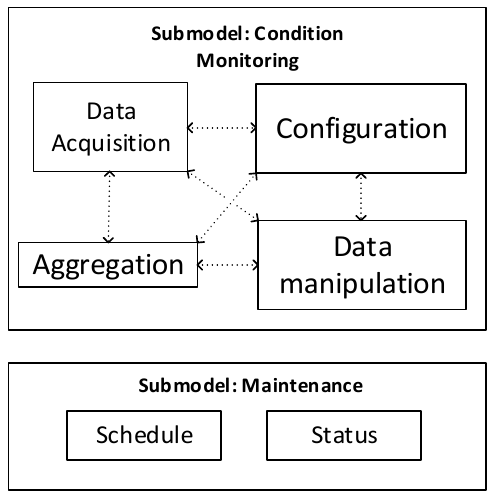
Figure 3. Submodel definition for condition monitoring and maintenance and the LBs they implement.